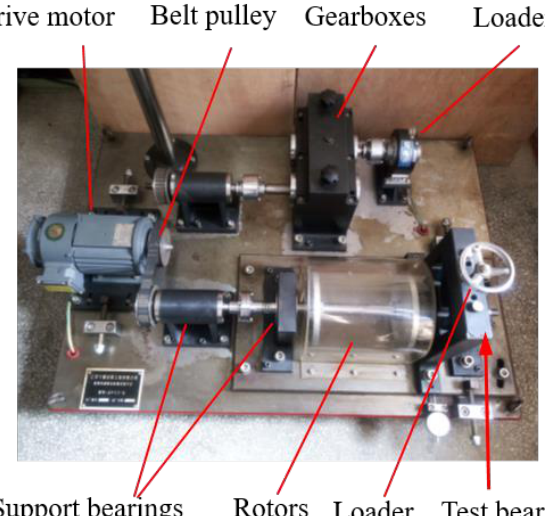
Figure 10. The test bench.